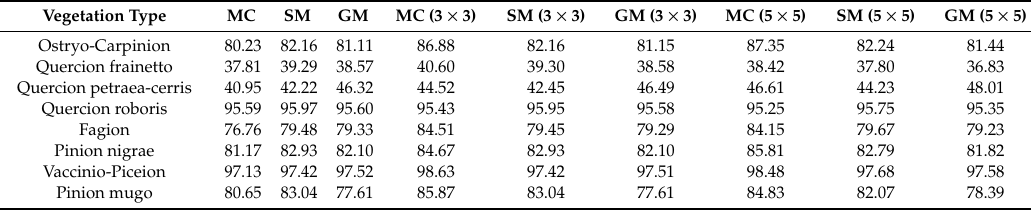
Table A3. Producer’s accuracy for all woody vegetation classes for 10-fold